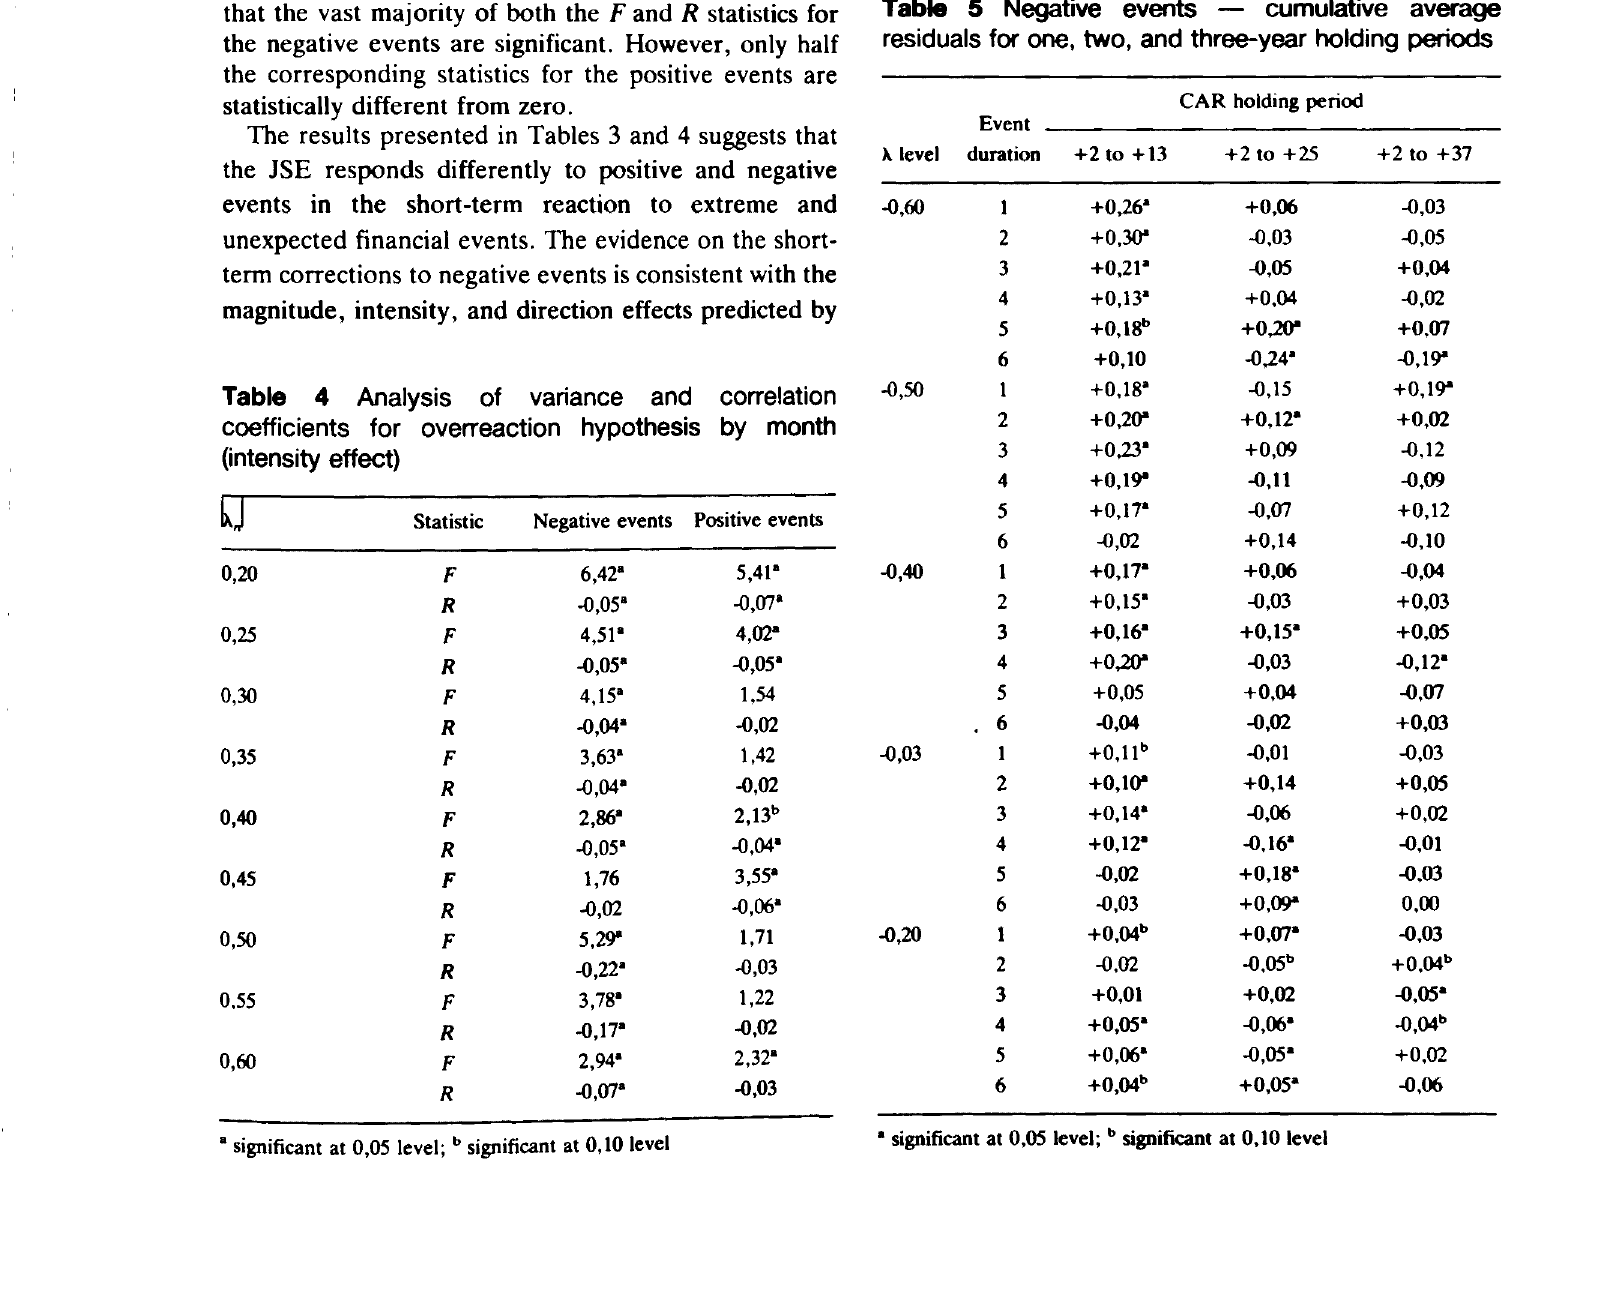
4 Analysis of variance and correlation coefficients for overreaction hypothesis by month (intensity effect) Statistic Negative events Positive